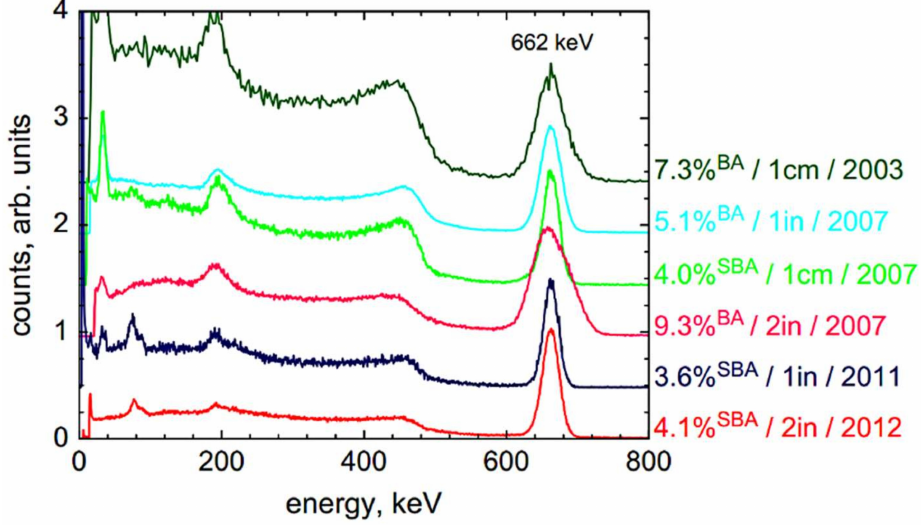
Figure 4. 137 Cs energy spectra measured for various CLYC crystals over time, showing the progress in the energy resolution and size (BA: bi-alkali, SBA: super bi-alkali PMTs). Reproduced with permission [34]. Copyright 2013, Elsevier